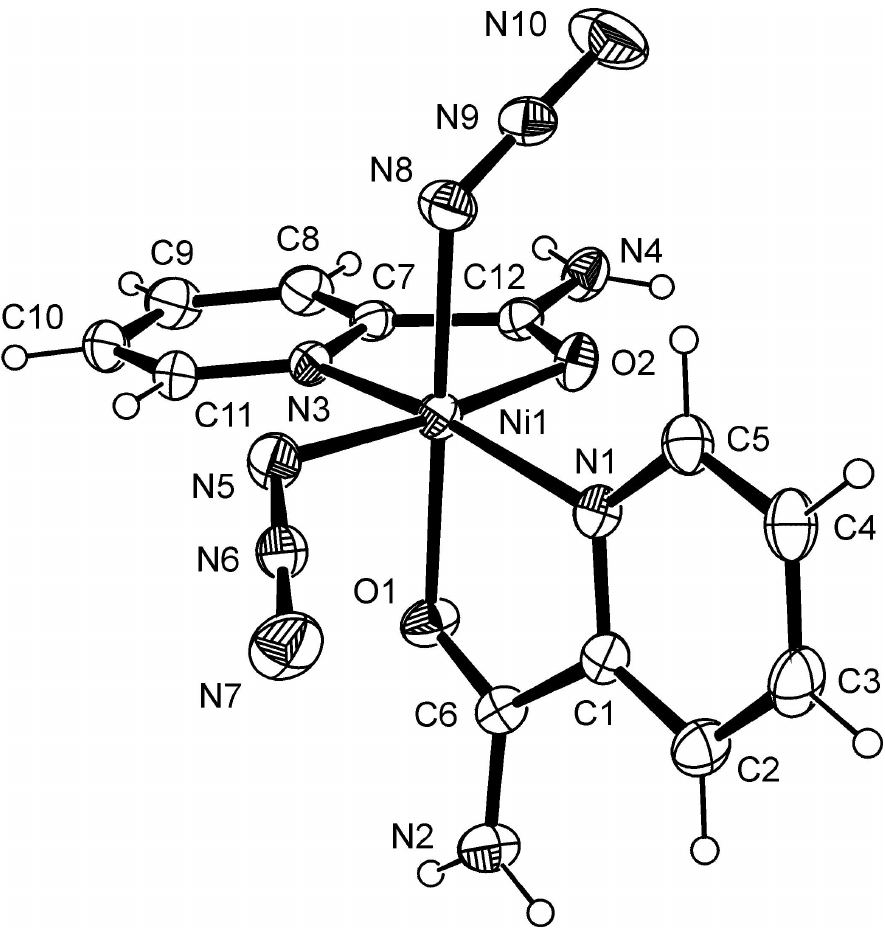
Figure 1 The ORTEP - 3 drawing of (I) with the atom numbering scheme. Displacement ellipsoids for non-H atoms are drawn at the 30% probability